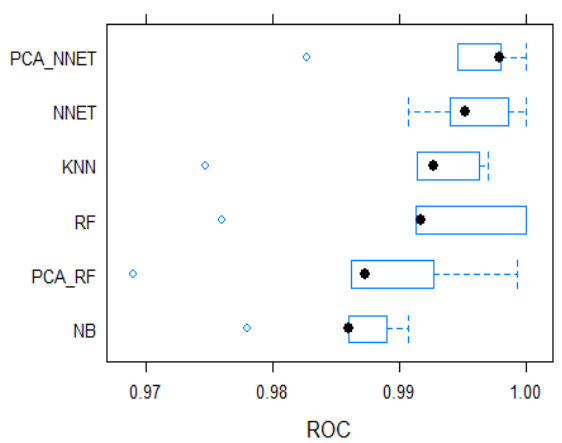
Table 3 in term of accuracy, sensitivity and specificity with different ranges of train-test spilt partitioning. Figure-3 shows ROC (Receiver Operating Characteristic) curve to analyze the performance of the model.